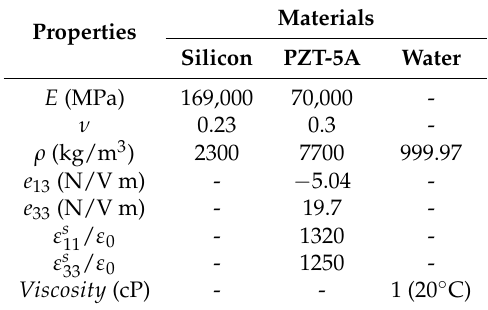
Table 2. The material properties.